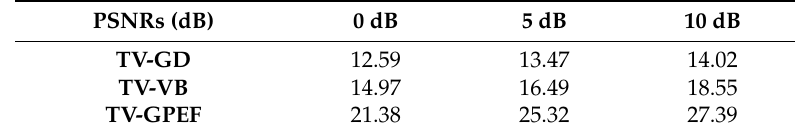
Table 3. PSNR (dB) of the reconstruction from the noise-added signals.